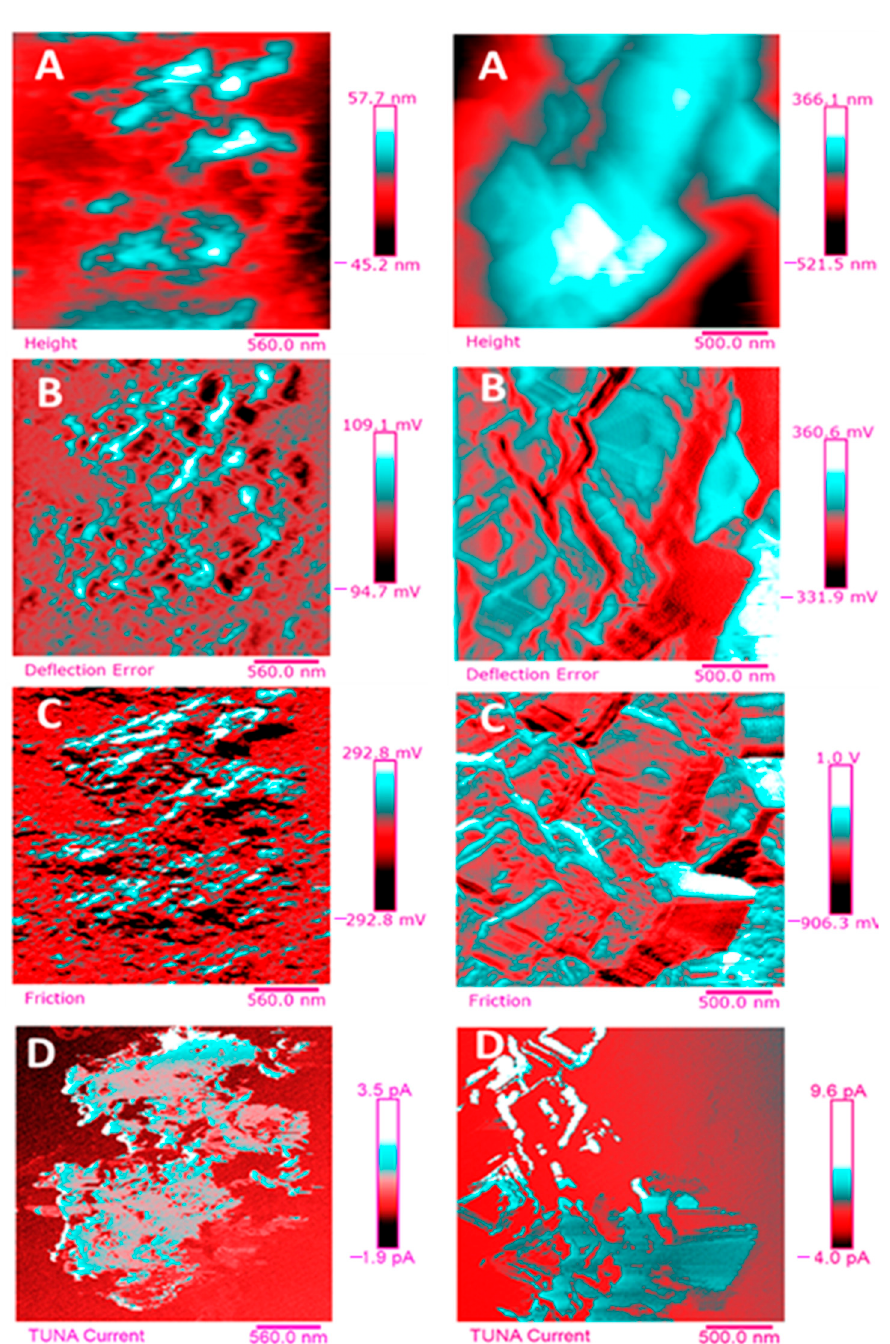
Figure 11. TUNA pictures (2D modality): ( A ) Height; ( B ) Deflection Error; ( C ) Friction; ( D ) TUNA Current of TCTBD+0.5%MWCNT-b (on the left) and TCTBD+0.5%MWCNT-t (on the right).